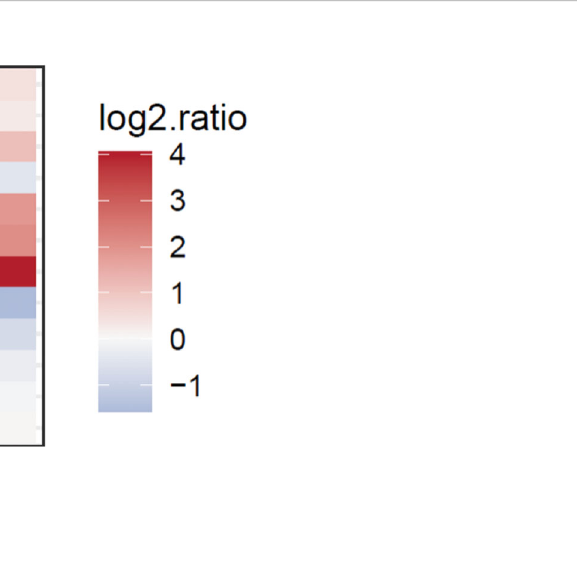
FIGURE 5 Heatmap of the signal of proteins over- and under-represented in the E. coli condition versus control, shown for both “ E. coli vs control ” and “ S. aureus vs control ”